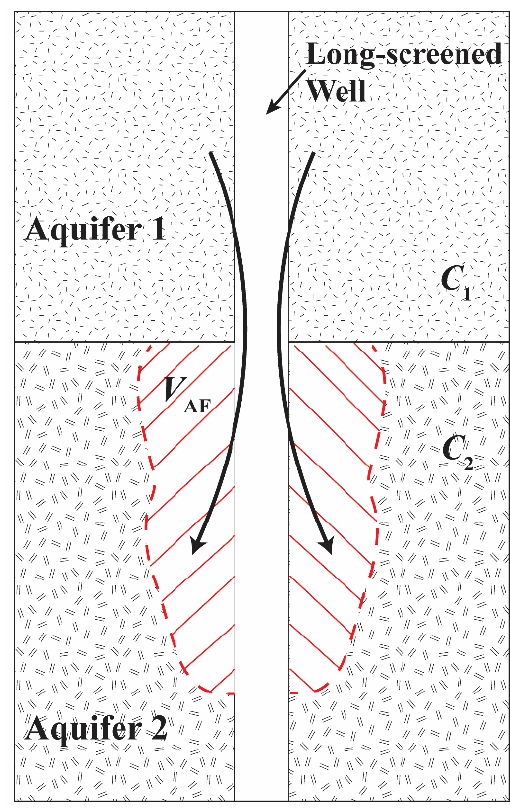
Figure 3. Conceptual model of ambient flow from high hydraulic head Aquifer 1 to low hydraulic head Aquifer 2.